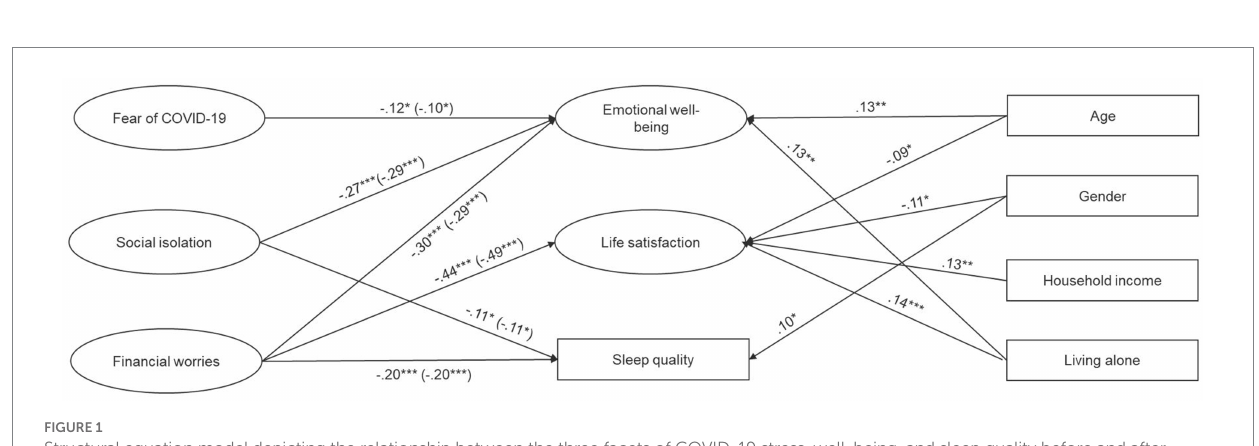
FIGURE 1 Structural equation model depicting the relationship between the three facets of COVID-19 stress, well-being, and sleep quality before and after controlling for age, gender, household income, and living alone. N = 480; gender: 1 = female, 2 = male; living alone: 1 = yes, 2 = no; * p < 0.05, ** p < 0.01, *** p < 0.001. Only significant paths are depicted; values in brackets represent path coefficients for the model without the control variables; correlations between the predictors and control variables are not depicted for easier readability (see Table 2 for bivariate correlation